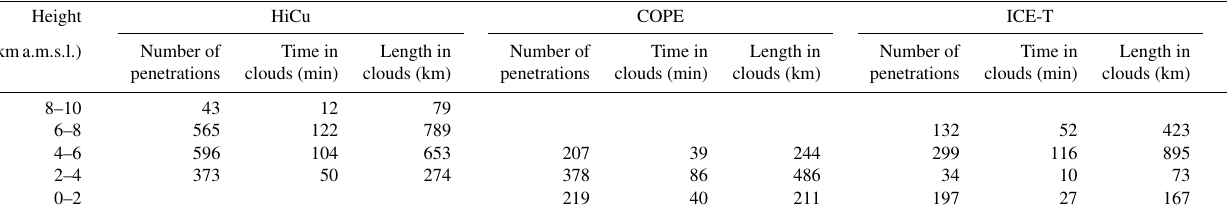
Table 1. Number of penetrations, time in clouds, and flight length in clouds sampled at 0–2, 2–4, 4–6, 6–8, and 8–10kma.m.s.l. in HiCu, COPE, and ICE-T.